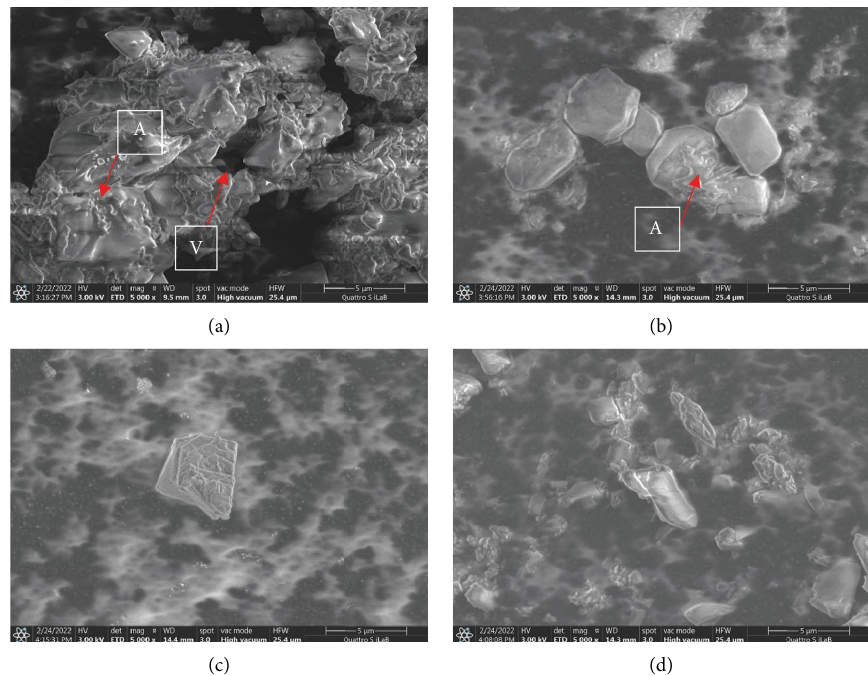
Figure 1: Scanning electron microscopy (SEM) images with 5000x magnifcation of cocrystallized moringa leaves extract powders (a). Vacuum-dried moringa leaves extract powders (b). Plated moringa leaves extract powders (c). Sucrose (d), V � void, and A �